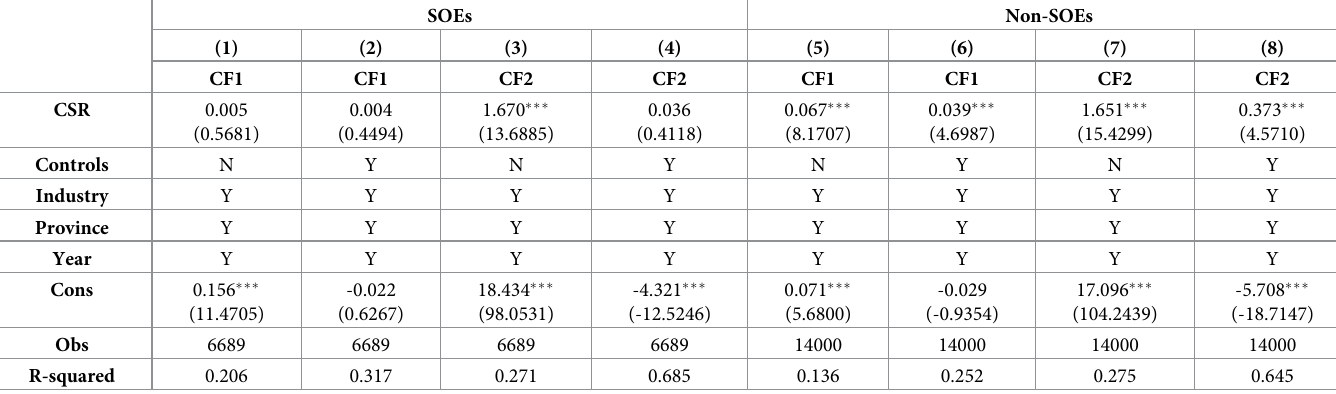
Table 4. Sample regression of state-owned and non-state-owned enterprises.